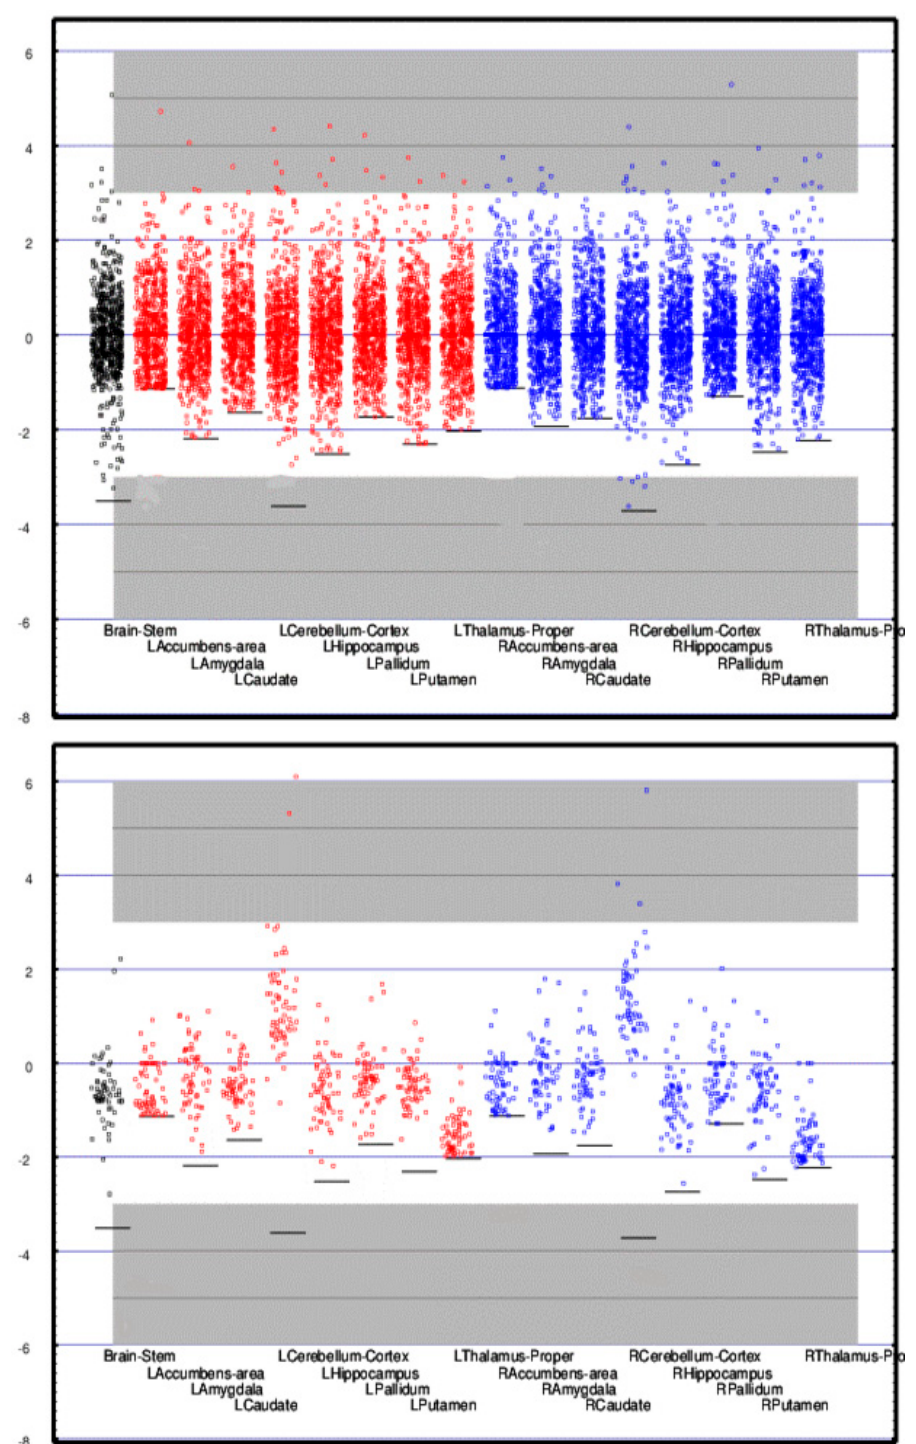
Figure 4. Regional activity ( z-score ) for 17 subcortical regions is shown for each CamCAN ( upper panel) and TEAM-TBI ( lower panel) subject. Since the means and standard deviations for the CamCAN subjects were used to compute the z-scores , the mean for each of the CamCAN regions is zero and the z-scores for each region are distributed approximately normally about zero. The mean and Scheme 3. 0 or z > 3.0—i.e., p < 0.0014. Individuals whose measures fall into those portions of the graph that are highlighted in gray are far from the norm. Note that assessing sub- mean normality is limited by the floor.